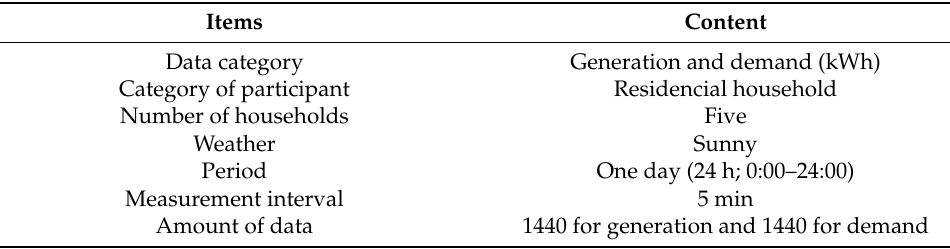
Table 1. Data used in the artificial market simulation.